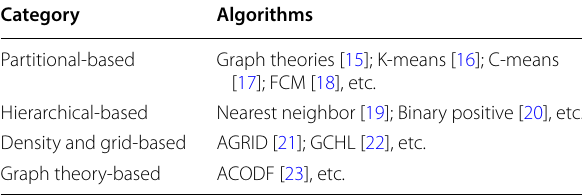
Table 1 Clustering technology lists Category Algorithms